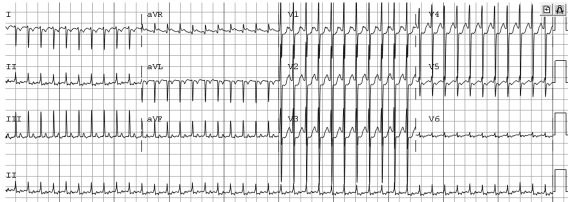
Figure 2: 12-lead electrocardiogram obtained during an episode of supraventricular tachycardia (HR: 260